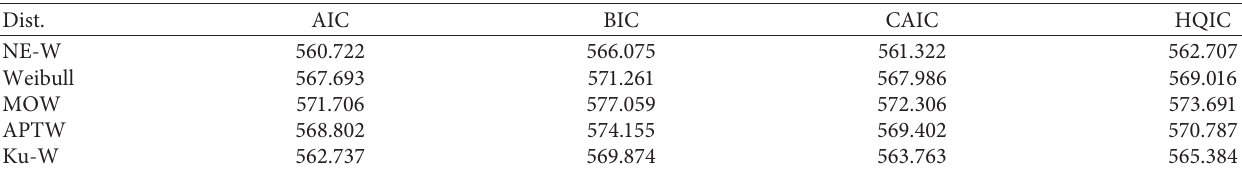
Table 7: The analytical measures of the fitted models for data 2.